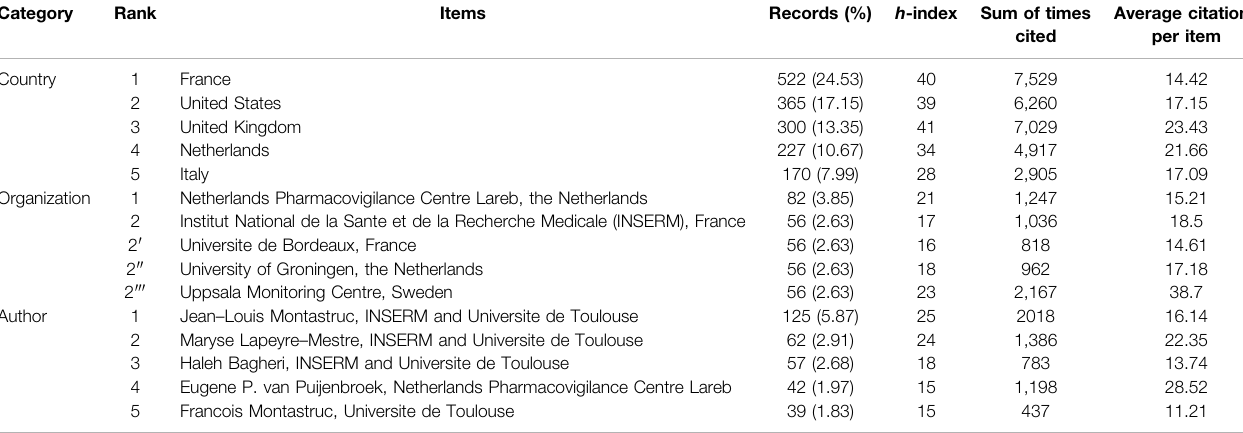
TABLE 1 | The top fi ve high-yield countries, organizations, and authors on pharmacovigilance from 1974 to 2021. Category Rank Items Records (%) h -index Sum of times